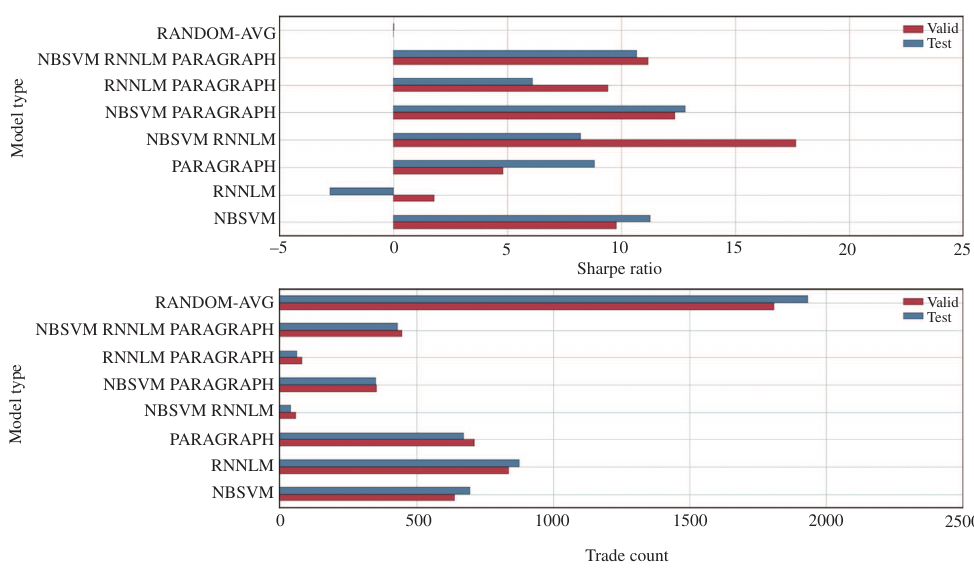
Figure 4: Performance of Language Models on 240-Min Exit